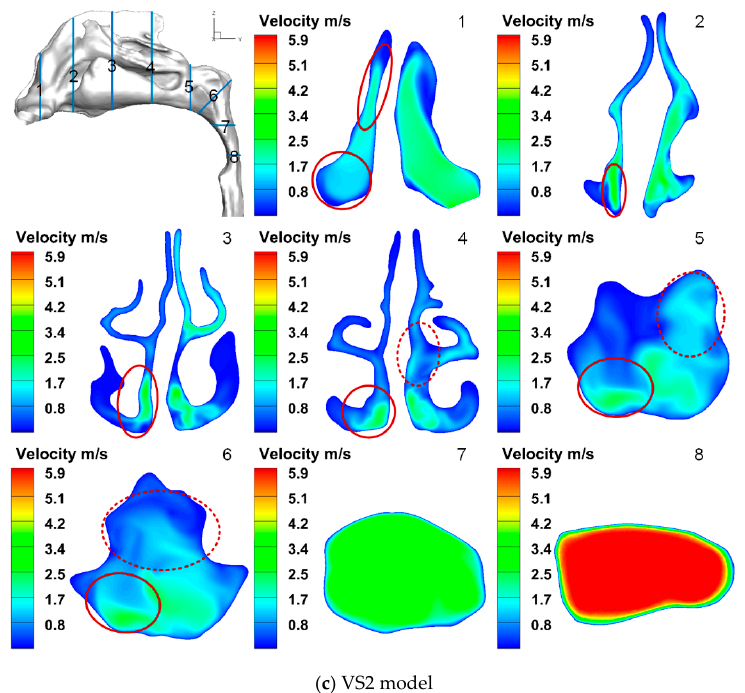
Figure 3. Velocity distributions of cross-sections of the nose-to-throat models at 15 L/min.